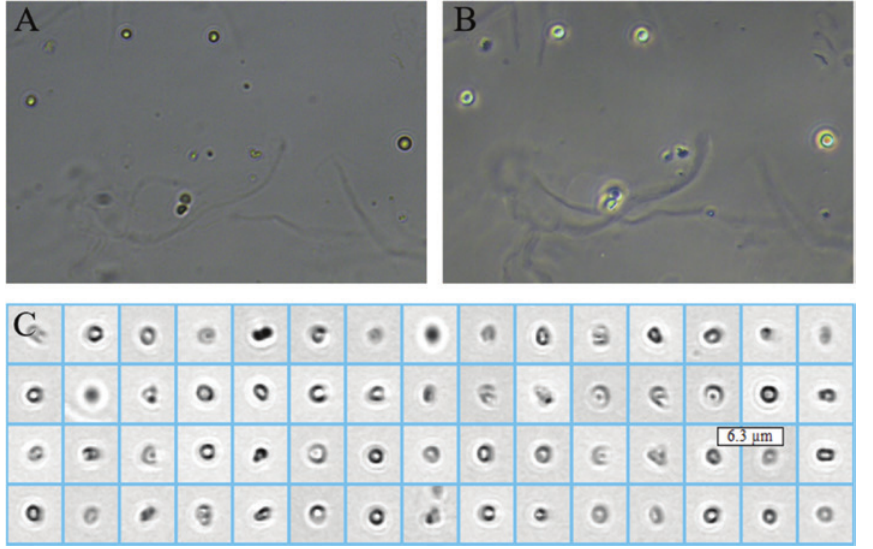
Figure 2: Small red blood cells. (A) Bright field, (B) phase-contrast microscopy (all images: original magnification, × 400). (C) A large number of small red blood cells with a diameter of about 6.3 μ m were found in the unclassified list of